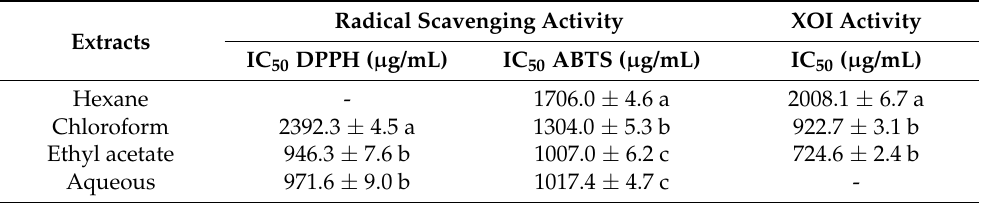
Table 2. Xanthine oxidase inhibitory and antioxidant activity of kava root extracts as IC 50 values Extracts